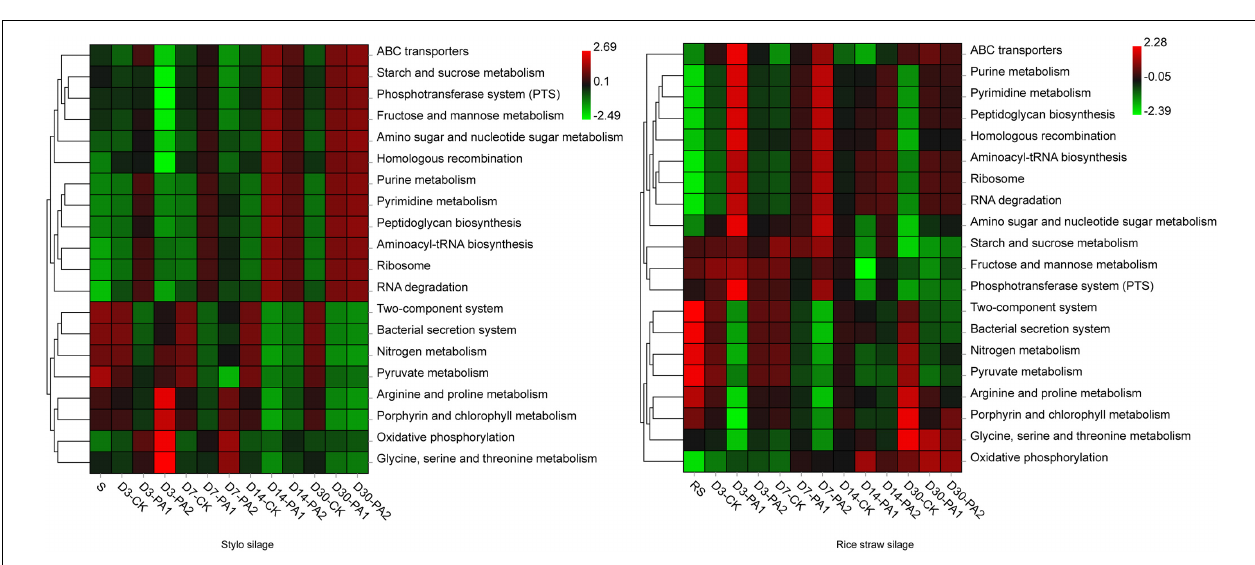
lactic acid using water-soluble carbohydrates as